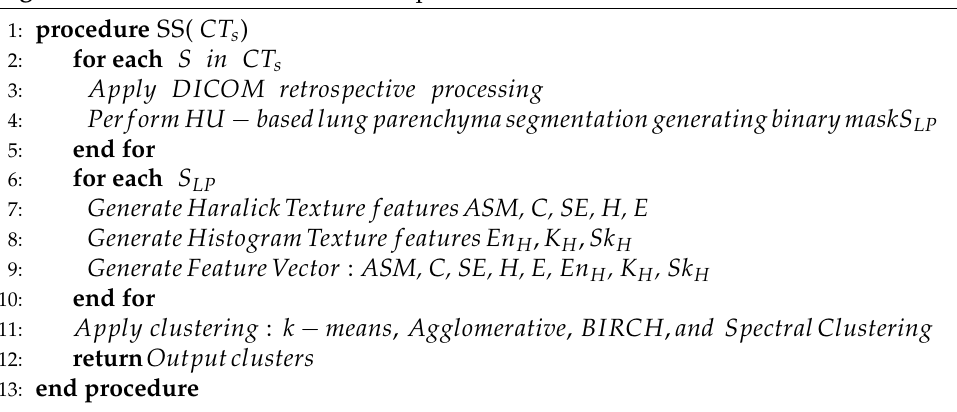
Algorithm 1 Radiomics-based semi-supervised slice